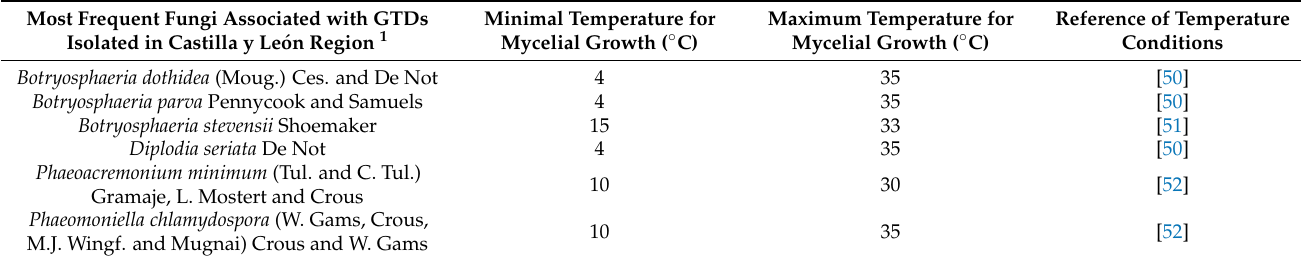
Table 2. Temperature growth range of the main fungi associated with GTDs in Castilla y Le ó n region. Most Frequent Fungi Associated with GTDs Isolated in Castilla y Le ó n Region